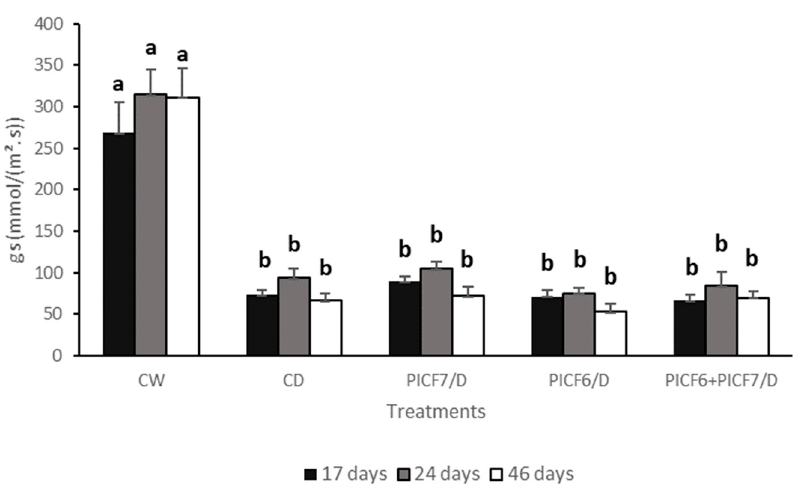
Figure 8. Stomatal conductance (gs) in olive plants (cv. Picual) leaves subjected to drought stress. CW, control plants solely irrigated with water; CD, plants subjected to drought stress with no water; PICF7/D, plants inoculated with Pseudomonas simiae PICF7 without subsequent watering; PICF6/D, plants inoculated with Pseudomonas sp. PICF6 without subsequent watering; PICF6+PICF7/D, plants co-inoculated with PICF6 and PICF7 without subsequent watering. Error bars represent the standard error of the means ( n = 9). Letters represents significantly differences among treatments at the same sampling time according to Tukey (HDS) test ( p = 0.05). This experiment was performed twice with similar results.